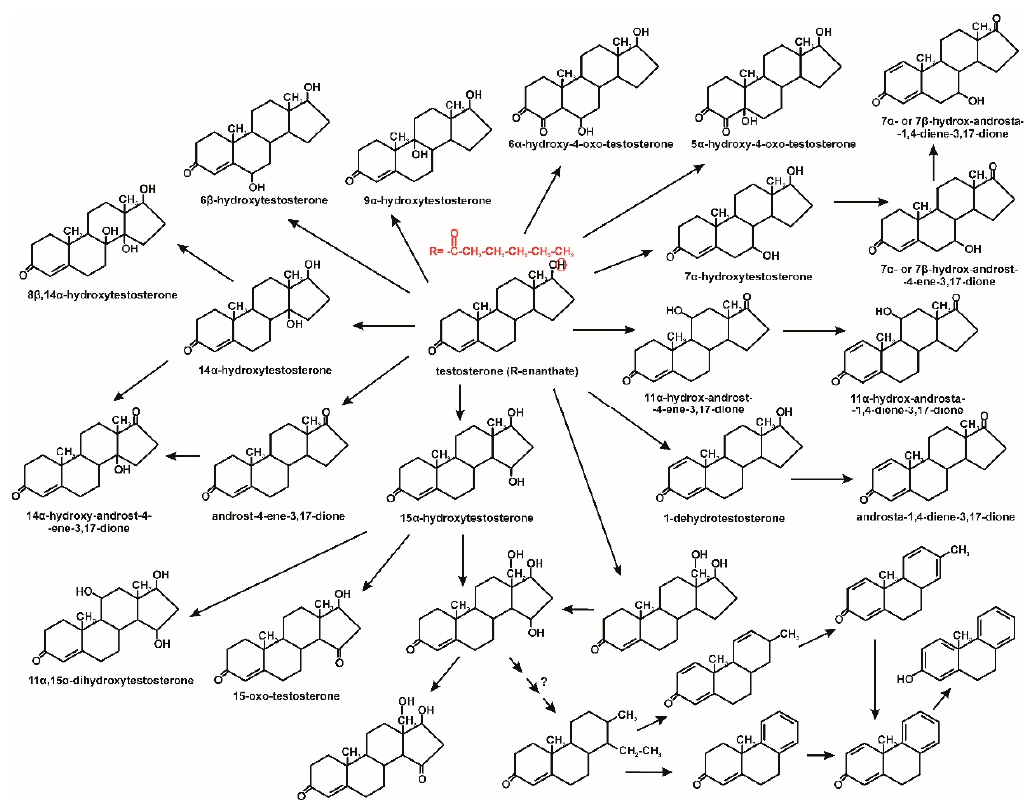
Figure 8. Testosterone and its derivatives biotransformation by fungi [43,44,46].